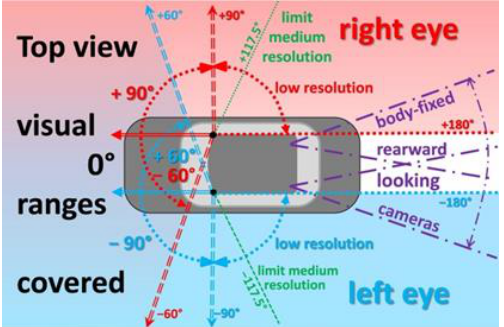
Figure 19. Coverage of the environment with two gaze-controlled tri-focal eyes for the front hemisphere and two body-fix cameras for the rear one.